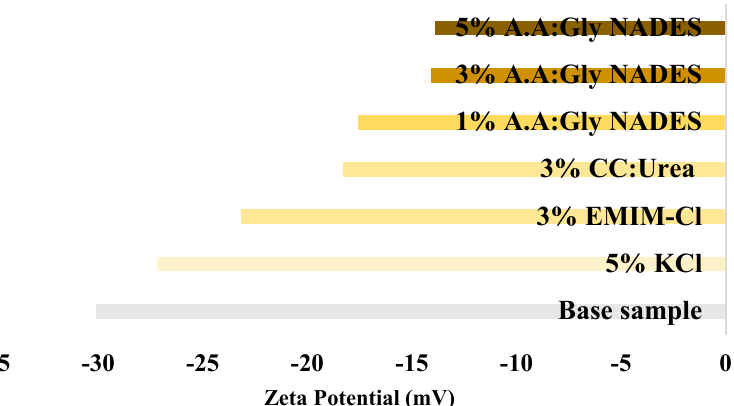
Figure 11. Zeta Potential of inhibitors-based drilling mud samples.